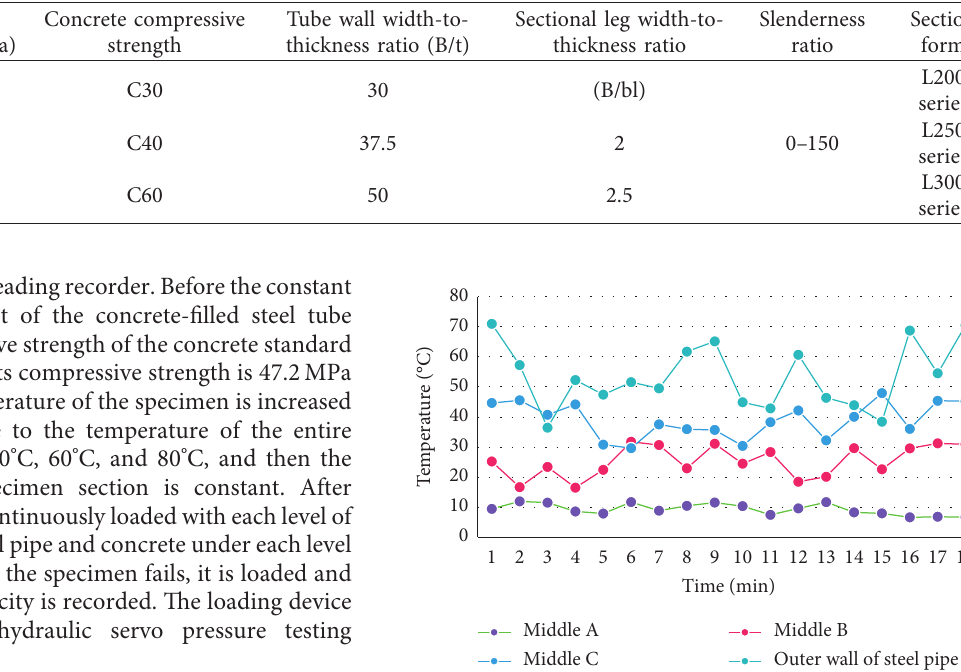
Table 1: Values of different